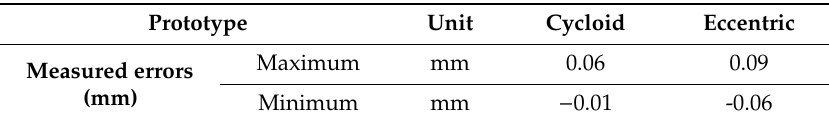
( b ) Figure 13. Measured shape of magnet: ( a ) cycloid; ( b ) eccentric. Table 5. Measured errors. Prototype